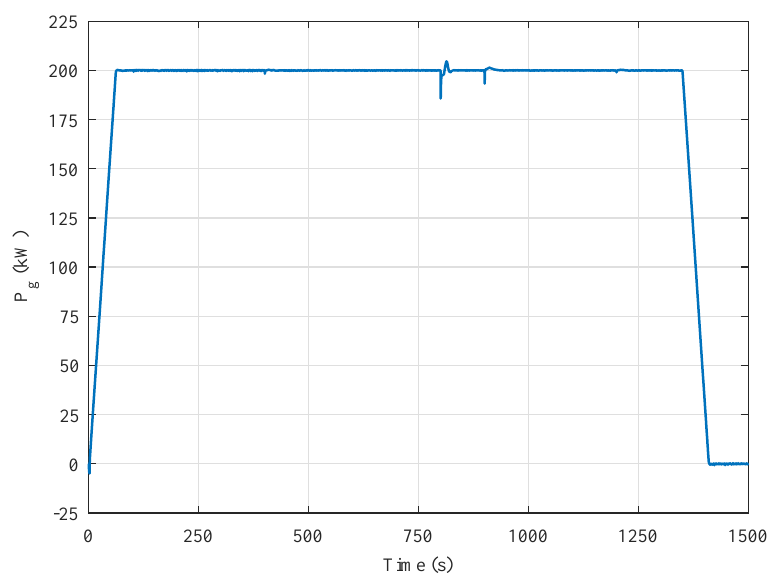
Figure 14. Time response of the total active power injected into the grid by the concentration photovoltaic (CPV) plant.